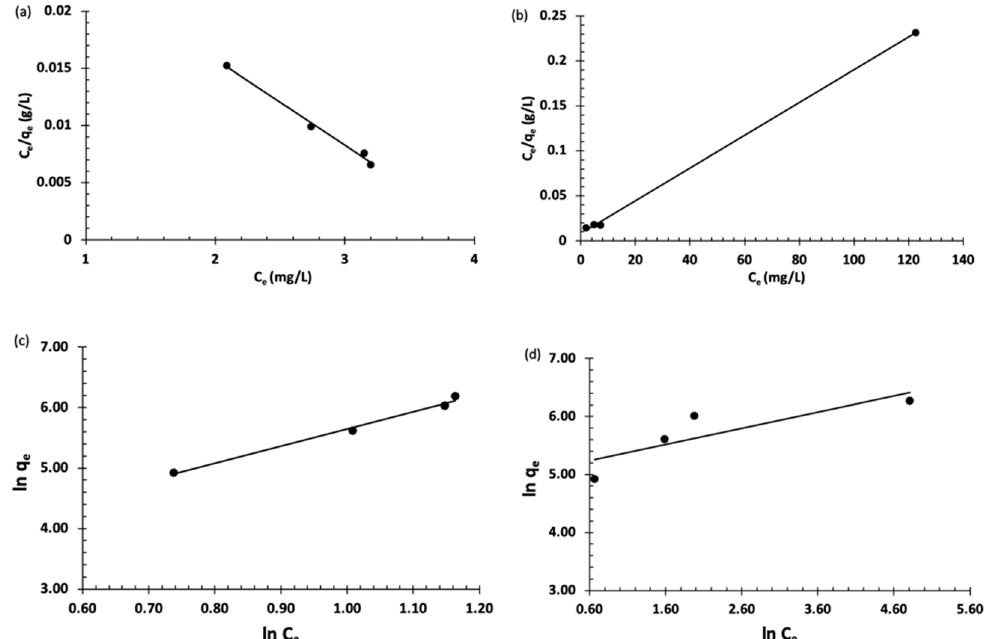
Figure 7. ( a , b ) Langmuir isotherm for the adsorption of bromothymol blue and methyl orange, re- spectively, at pH = 7 and 25 °C. ( c , d ) Freundlich isotherm for the adsorption of bromothymol blue and methyl orange at pH = 7 and 25 °C.